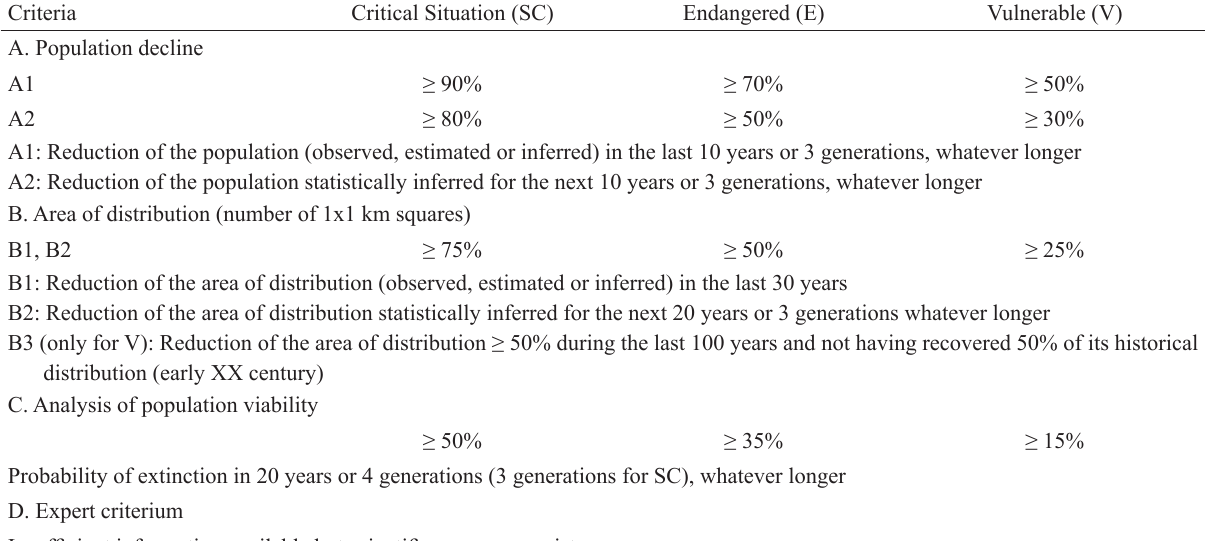
Table 4. Criteria for the assignment of categories SC, E and V in the Spanish Catalogue of Threatened Species (CEEA). Published at Resolution 2977 on March 6 th